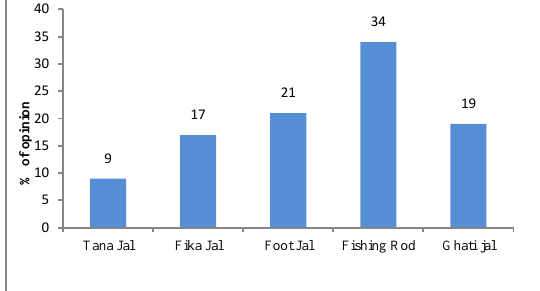
Figure 1: Graphical presentation of respondent opinion about cause of abandonment of Attu fish and most suitable techniques for catching this.